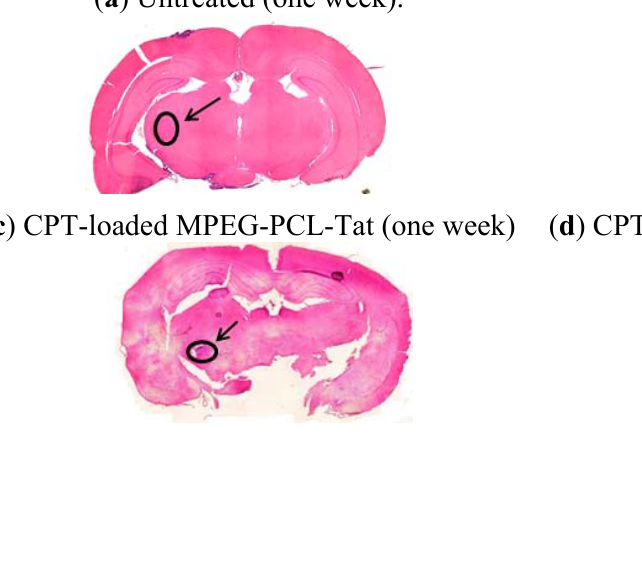
Figure 3. Photographs of HE stained brain tissue from an untreated rat one ( a ) and two ( b ) weeks after and a rat treated with CPT-loaded MPEG-PCL-Tat one ( c ) and two ( d ) weeks and 120 days ( e ) after. ( f ) Tumor volume after one and two weeks of no treatment (grey) or treatment with CPT-loaded MPEG-PCL-Tat (black) (mean ± S.E., n = 3). ( a ) Untreated (one week). ( b ) Unteated (Two week).